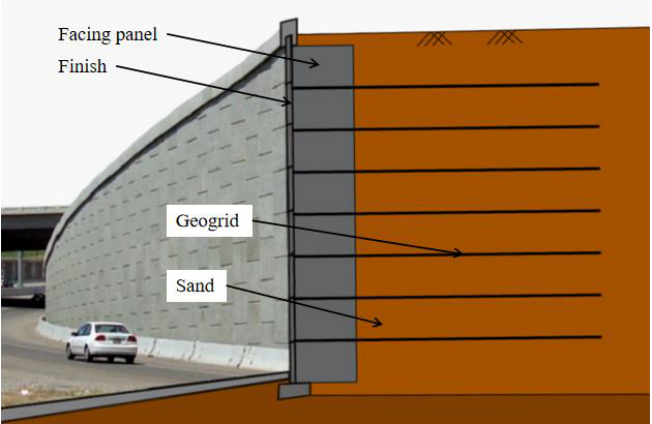
Figure 1. Structural form of geogrid reinforced retaining wall.